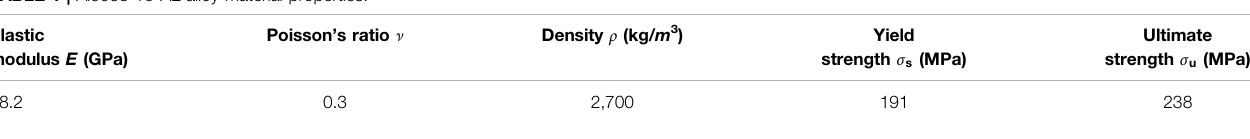
TABLE 1 | Al6063-T5 AL alloy material